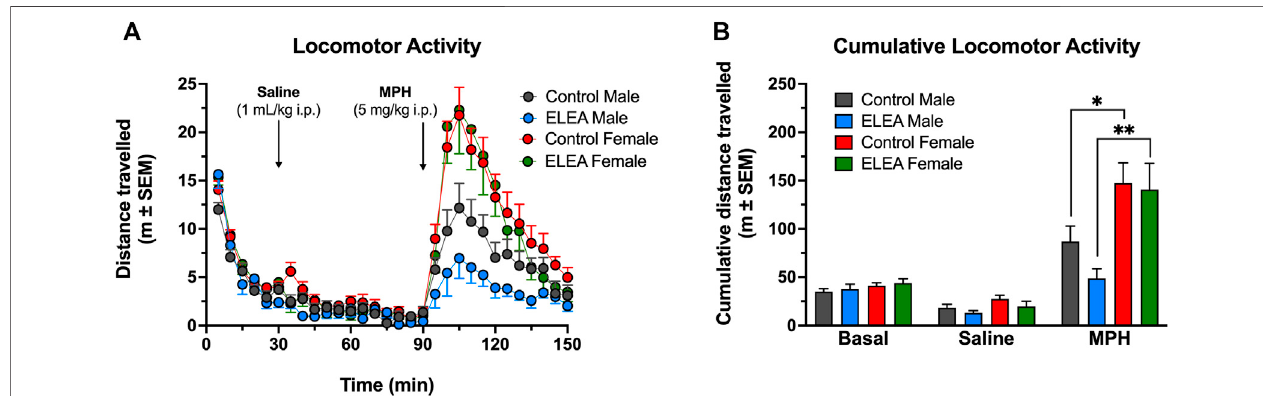
FIGURE3| ELEAeffectsonlocomotoractivityofadultrats. (A) Therewerenodifferencesinbasallocomotoractivitynorwhenratswereinjectedwithsalinesolution (1 ml/kg, i. p.). 15 min after drug administration (MPH; 5 mg/kg, i. p.) ELEA female rats showed higher locomotor activity than ELEA males (*** = p < 0.001). (B) Cumulativelocomotoractivityshowedfemalerats,bothcontrolandELEAanimals,travelledsigni fi cantlymoredistancethantheirmalecounterparts(*= p < 0.05;**= p < 0.01).Therewerenodifferencesincumulativebasaldistancetravelled,norwhensalinewasinjected(control males, n =11;ELEAmales, n =8;controlfemales, n = 12; ELEA females, n = 8).